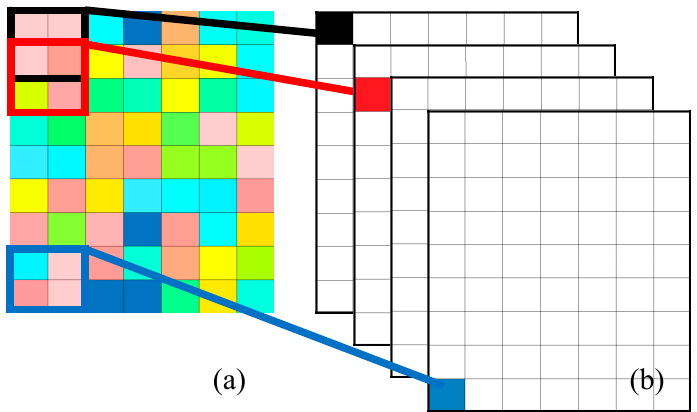
Figure 5. An example of a convolutional layer. ( a ) Multiscale signal and ( b ) output feature maps.